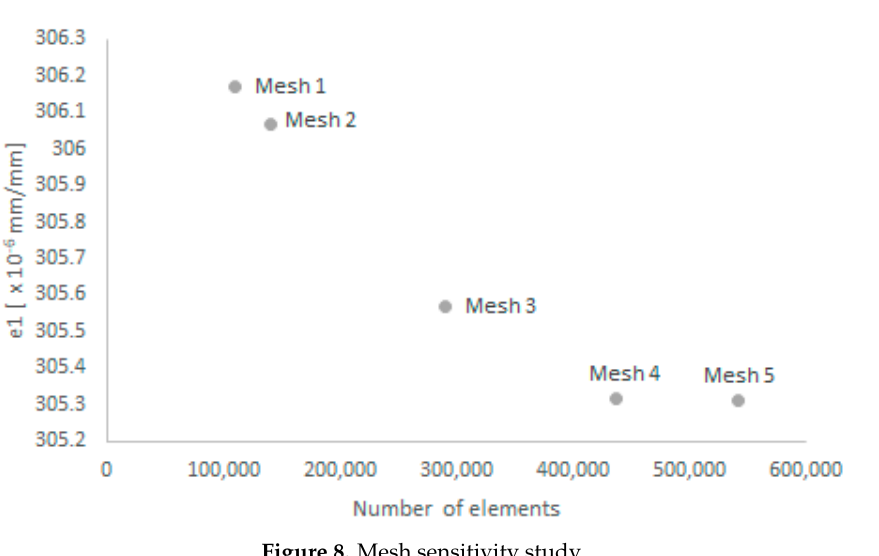
Figure 7. Finite element model with drilled hole.